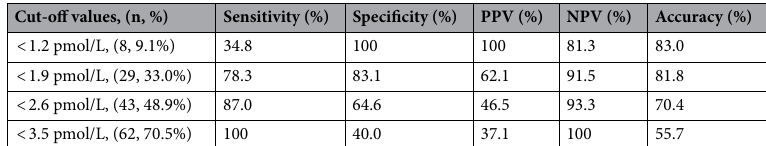
Cut-off values, (n, %)